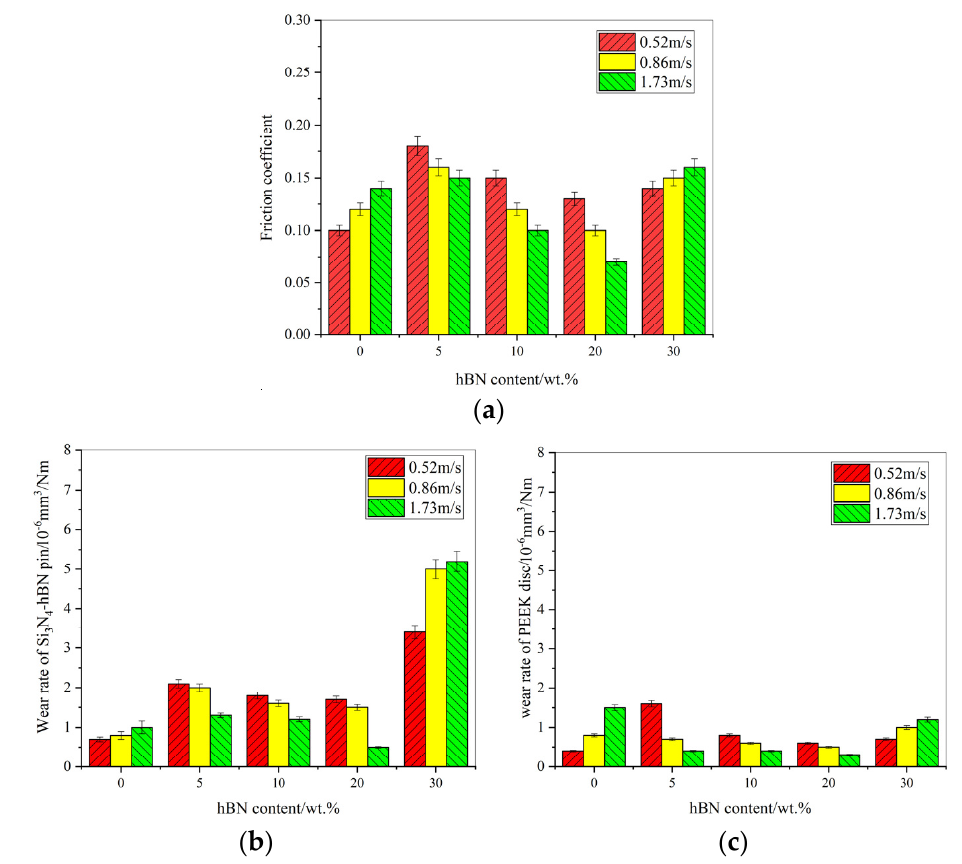
Figure 3. Friction coefficients and wear rates of Si 3 N 4 -hBN/PEEK pairs in artificial seawater: ( a ) friction coefficients; ( b ) wear rates of pins; ( c ) wear rates of discs.